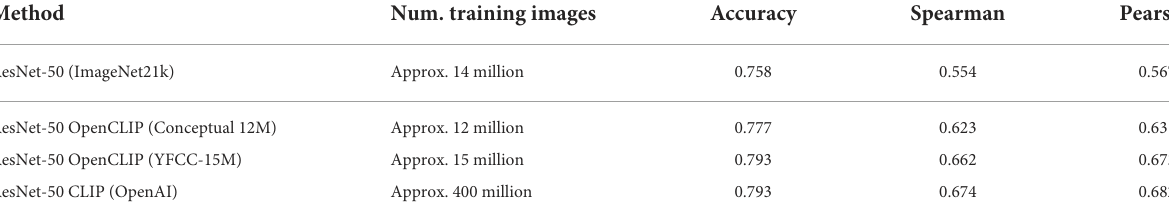
TABLE 2 Linear probing results for similar ResNet-50 (He et al., 2016)